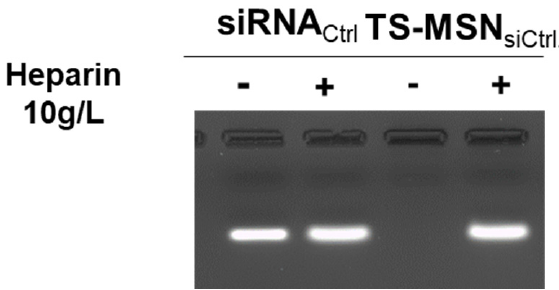
Figure 3. Gel retardation assay demonstrating the siRNA complexation in TS-MSN. siRNA formu- lated in TS-MSN in the presence (+) or absence (-) of heparin compared to naked siRNA. Lanes without heparin show free siRNA amount, and lanes with heparin show total siRNA amount in the sample. TS-MSN: targeted stealth magnetic siRNA nanovectors.